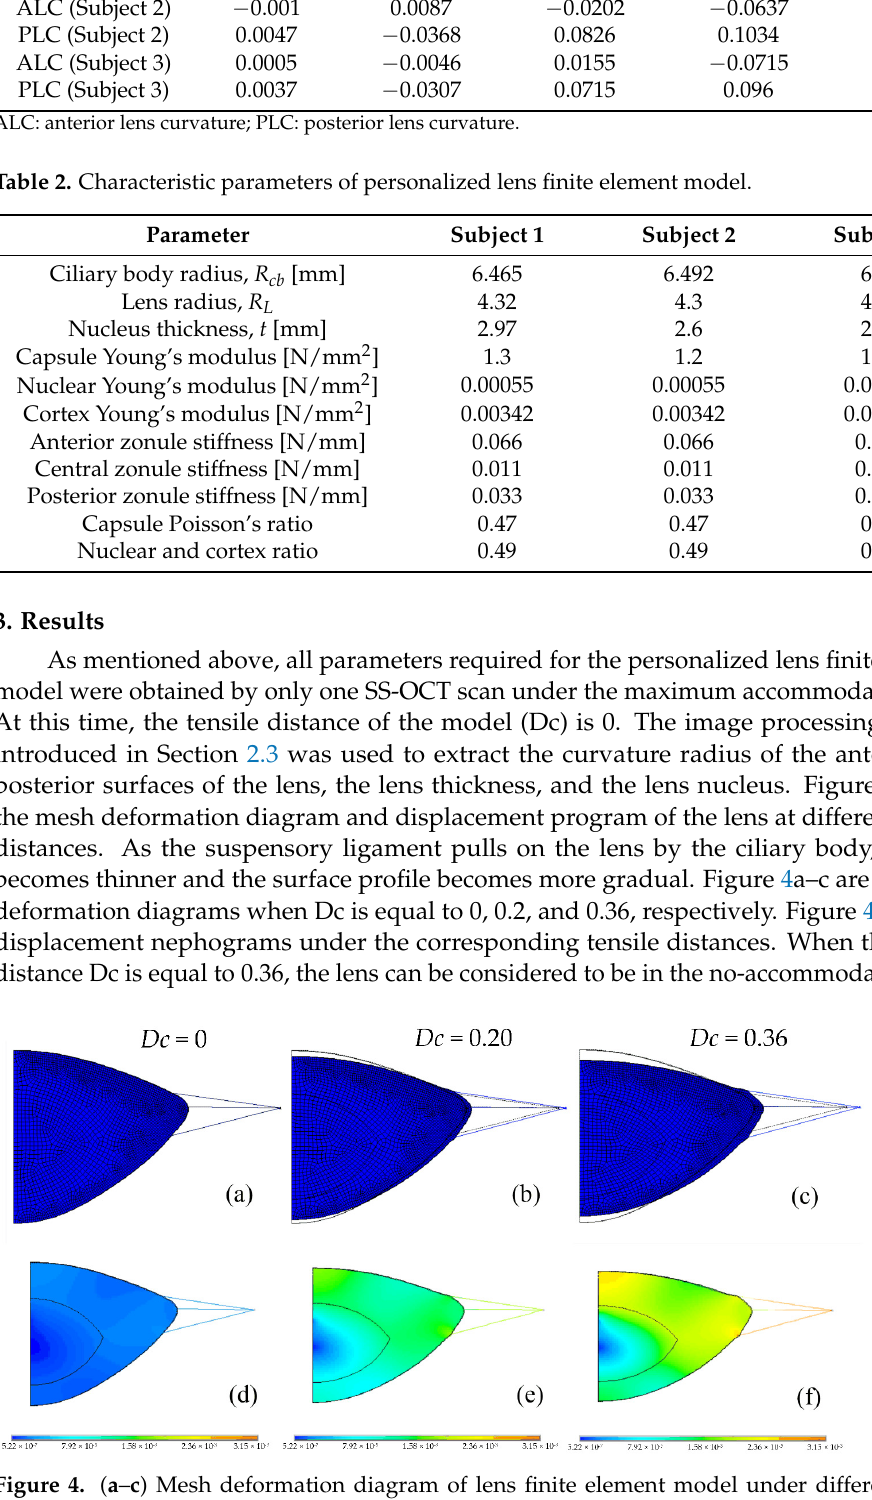
Figure 4. ( a – c ) Mesh deformation diagram of lens finite element model under different tensile distances; ( d – f ) The corresponding displacement